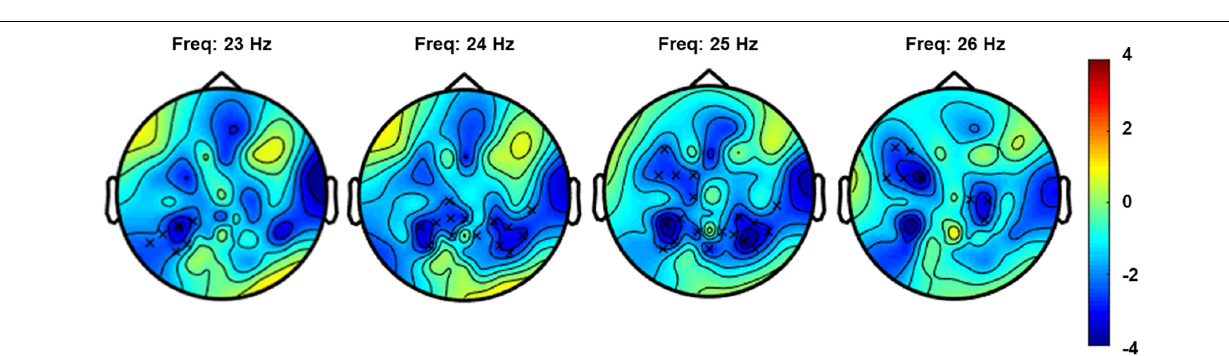
the frequency range of 17–21 Hz and including the following 11 clustered electrodes: AF3, AF4, AF7, AF8, Fp2, F1, F4, F5, F7, F8, and